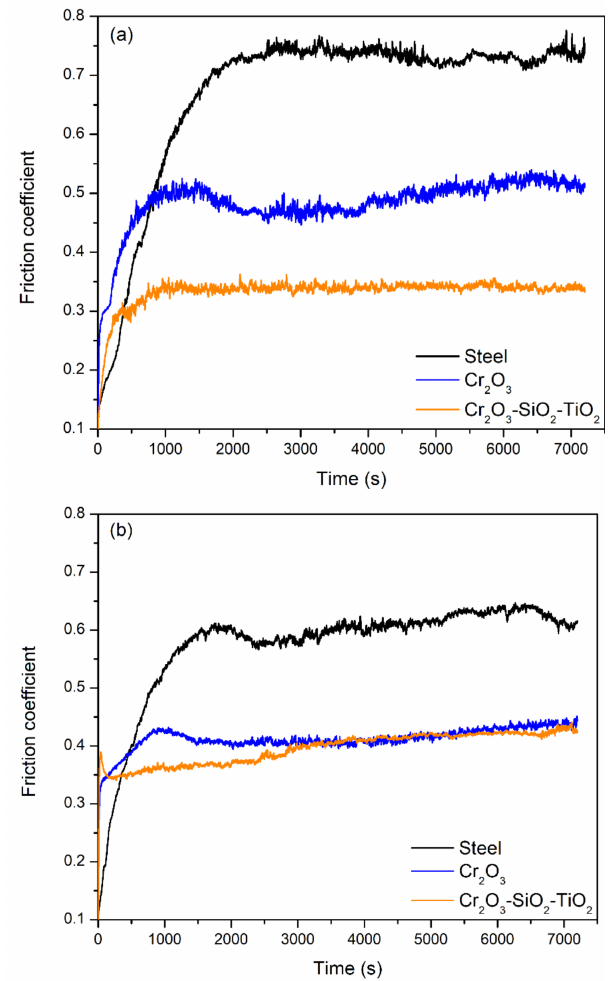
Figure 3. The variation of friction coefficients versus sliding time when ( a ) 1 N and ( b ) 3 N loads were